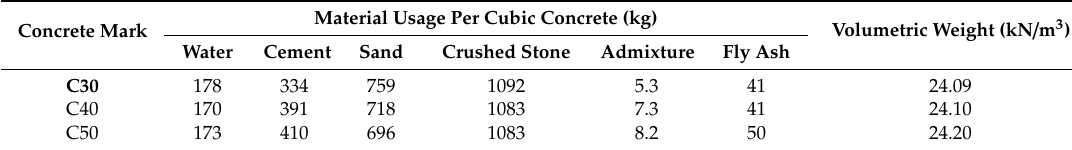
Table 2. SBCC specimens’ concrete mix ratio.